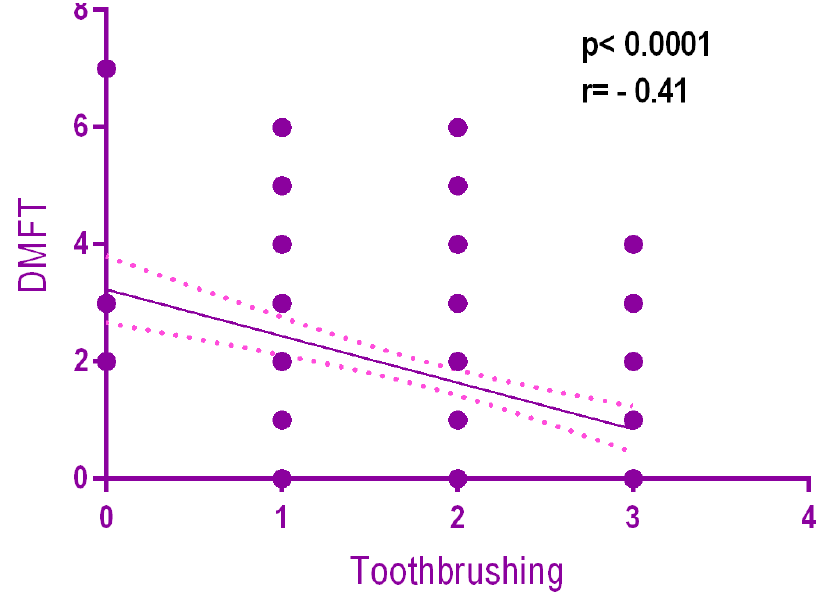
Figure 5. Relationship between DMFT and toothbrushing frequency. There was a weak but statistically significant positive relationship ( r = 0.25, p = 0.0015) between the DMFT and BMI percentile. The higher the BMI value, the higher the DMFT (Figure 6). There was no statistically significant positive relationship ( p = 0.0083) between the Mutans Streptococci levels according to the BMI (Figure 7). On the other hand there was a significant positive relationship ( p = 0.002) between Lactobacilli levels according to the BMI (Figure 8).